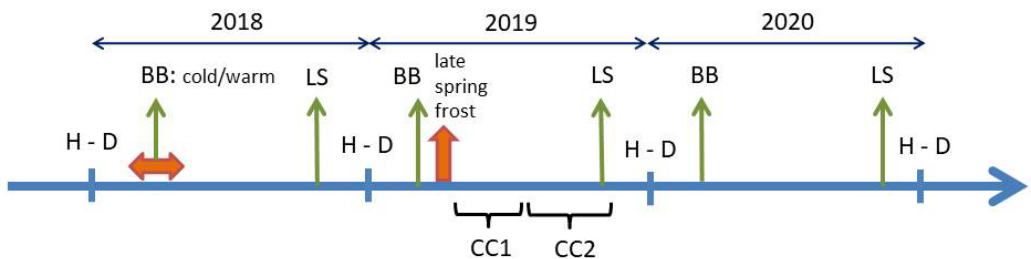
Figure 3. Time line indicating the temperature treatment in the spring of 2018 (horizontal red arrow), the frost event in the spring of 2019 (vertical red arrow) and measurements on the plants during the years 2018 till 2020. H: plant height; D: stem diameter; CC: relative chlorophyll content (CC1: up till 29 July, CC2: after 29 July); BB: bud burst and LS: leaf senes- cence.